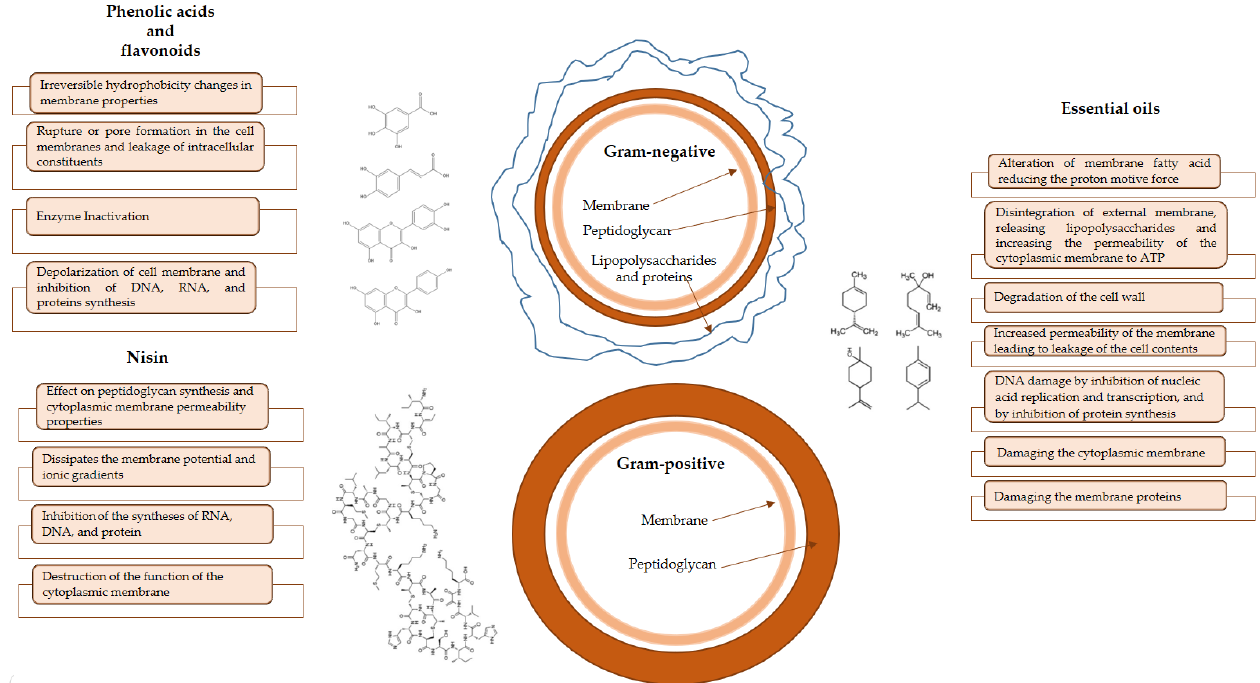
Figure 3. Action mechanism proposed for the different bioactive compounds added to chitosan edible films on microbial Gram-positive and Gram-negative cells. Table 1. Antimicrobial compounds added to chitosan-based composites for the development of bi- oactive chitosan edible films and coatings.